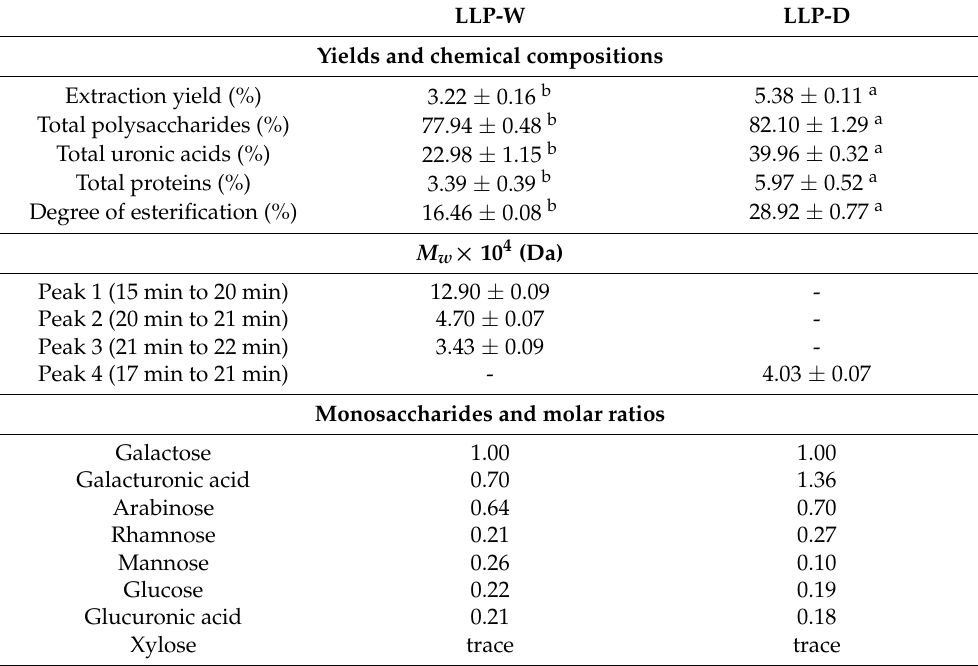
Table 3. Chemical compositions, molecular weight ( M w ), and molar ratios of constituent monosac- charides of polysaccharides extracted from lotus leaves. LLP-W LLP-D Yields and chemical compositions Extraction yield